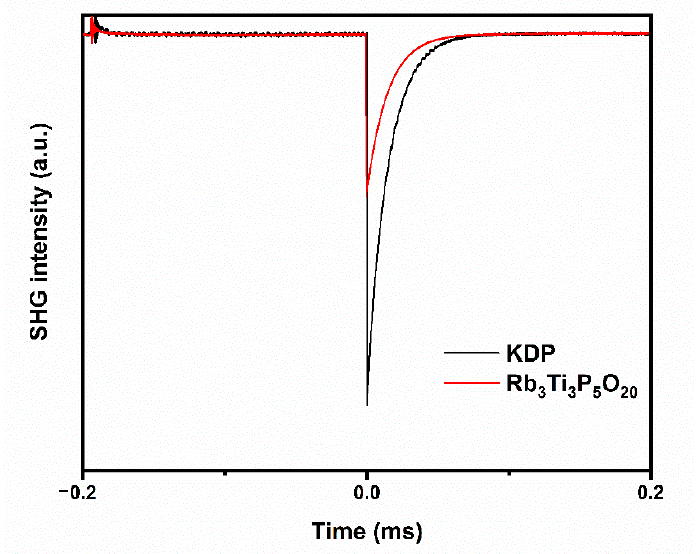
Figure 6. The SHG signals for Rb 3 Ti 3 P 5 O 20 and KDP standard sample.